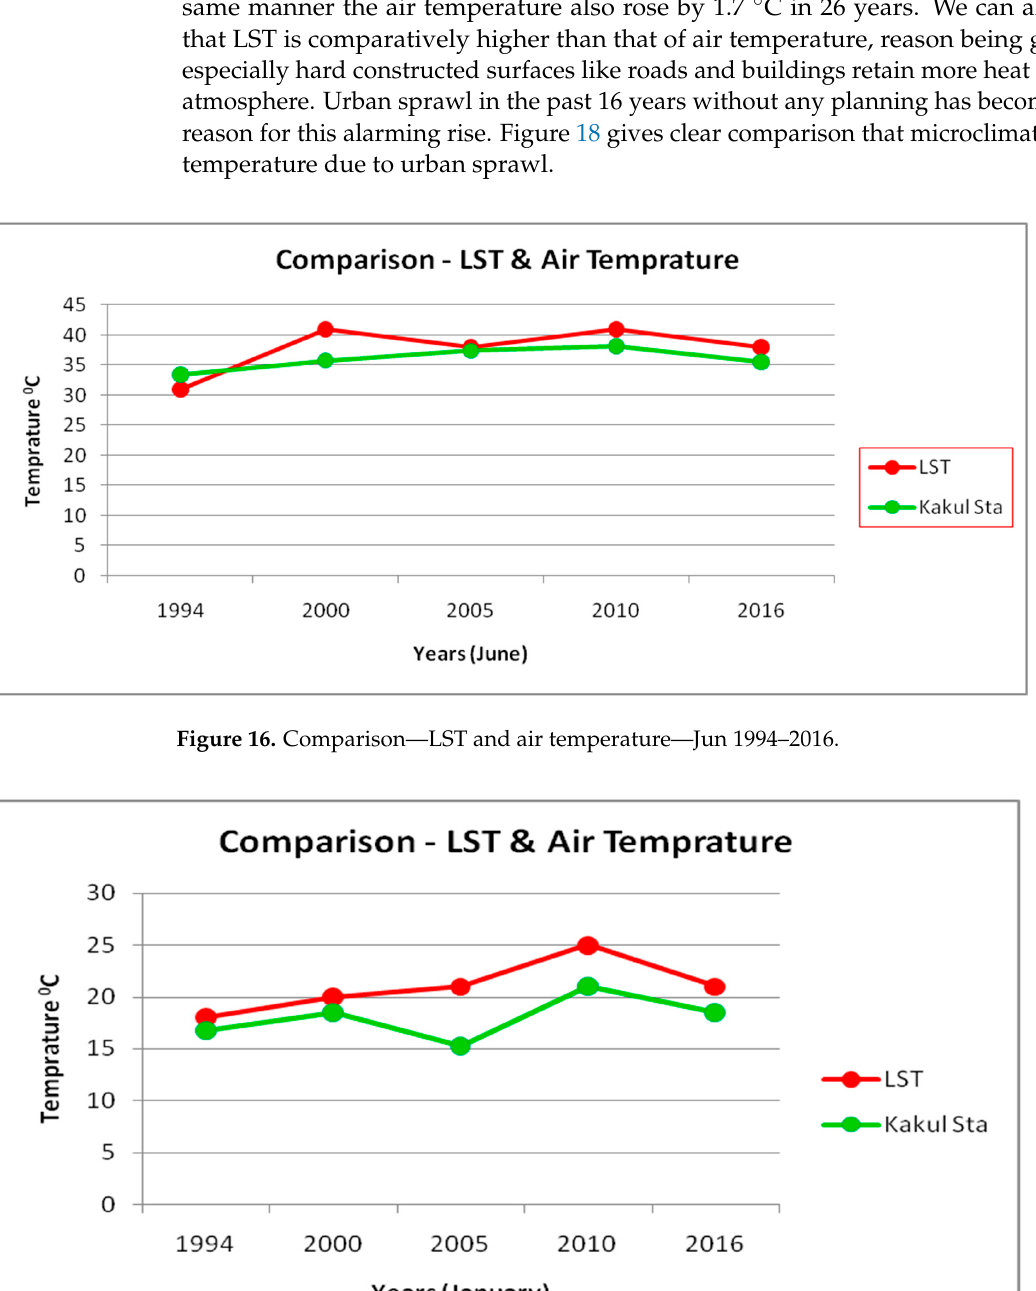
Figure 18. Overall comparison (urban sprawl, LST and air temperature).